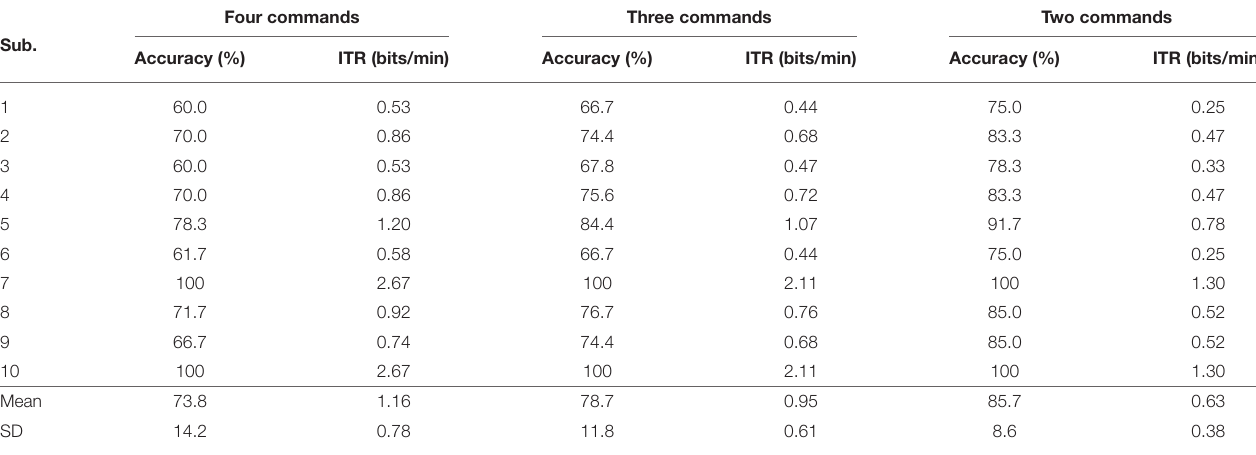
TABLE 3 | Detection performance when non-candidates for classification output were included in the learning.